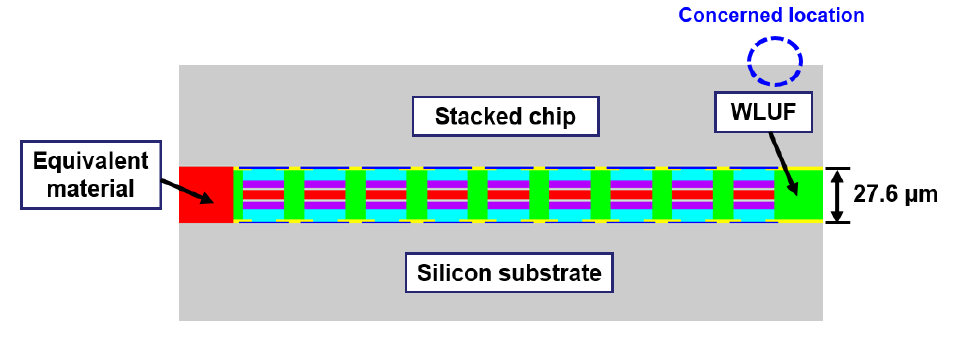
Figure 11. Inspected location of structural warpage considered in factorial